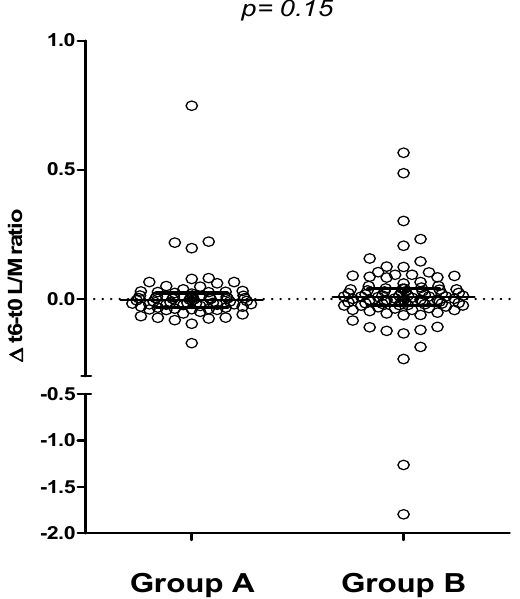
Figure 5. Comparison between t6 and t0 urinary L/M values in groups A and B ( ∆ t6-t0, median and